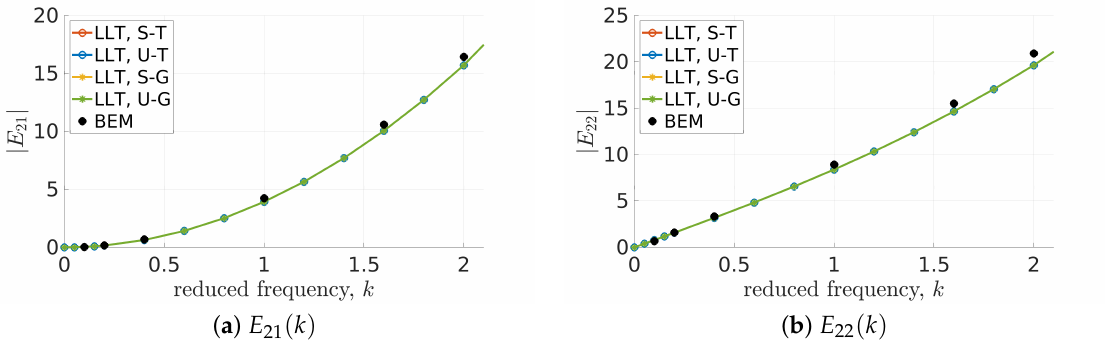
Figure 3. Magnitude of transfer functions E 21 ( k ) and E 22 ( k ) , constant shape functions, l =